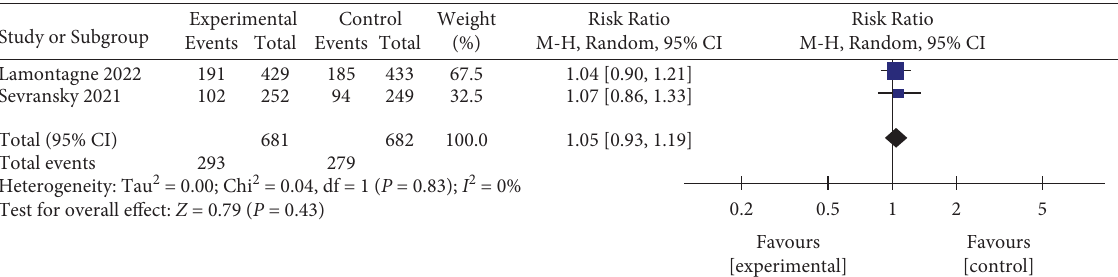
Figure 8: Forest plots for the efect of vitamin C on the 180-day mortality.